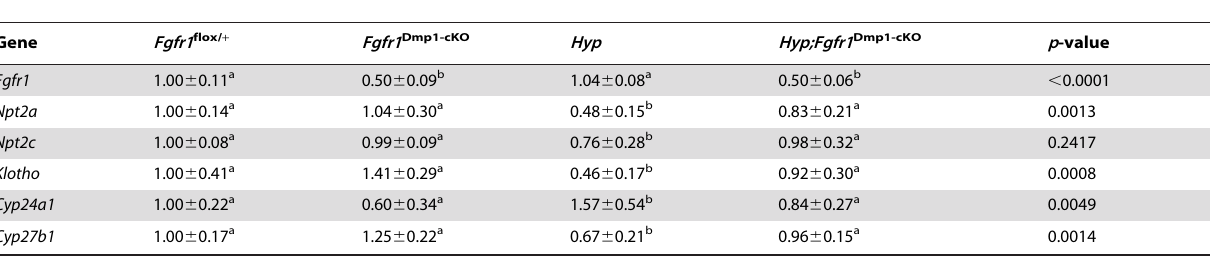
Data are mean 6 S.D. from 5–6 kidneys of 6-week-old individual mice and expressed as the fold changes relative to the housekeeping gene b -actin subsequently normalized to control mice. Values sharing the same superscript between two groups are not significantly different at P ,